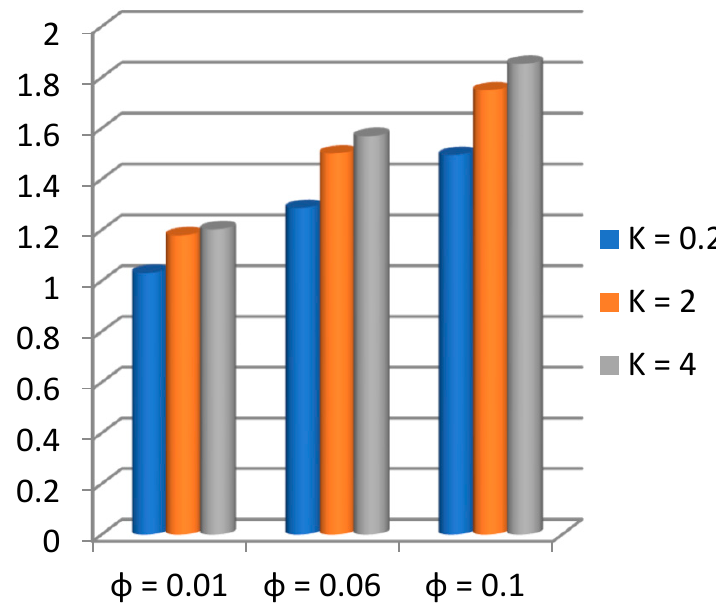
Figure 7. θ ( y ) for volume fraction of nanoparticles φ . Figure 7. 𝛉(𝐲) for volume fraction of nanoparticles 𝛟 .